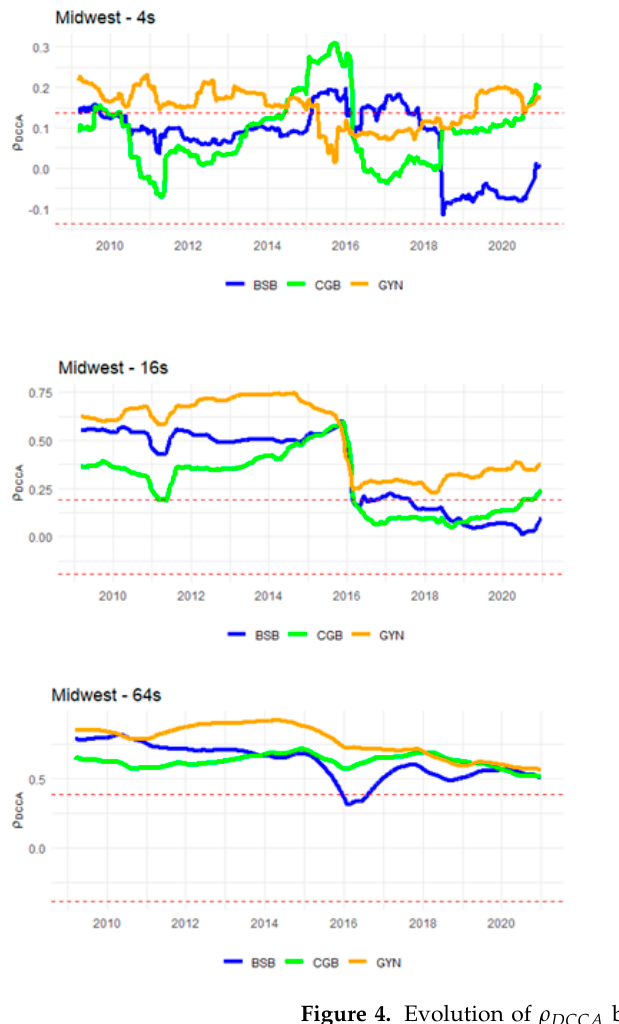
Figure 4. Evolution of ρ DCCA between the relative prices of S ã o Paulo and other capitals in the Midwest Region, with time scales of 4, 8, 16, 32 and 64 weeks, and moving window w = 250. Shaded lines are the upper and lower confidence intervals, in the sense that values between these are not statistically significant, according to the critical values of [66].